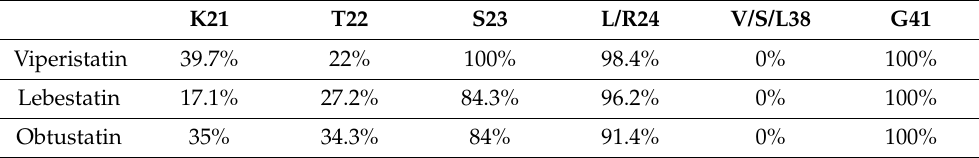
Table 1. Solvent accessible surface areas.